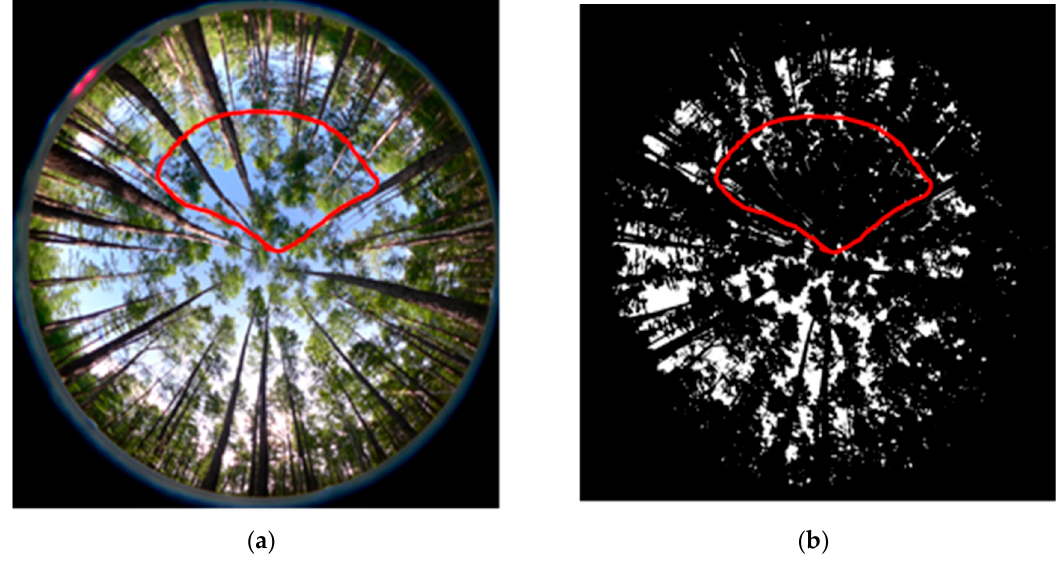
Figure 13. The segmentation result of the canopy image containing the blue sky. ( a ) Original image; ( b ) segmented image by our method.